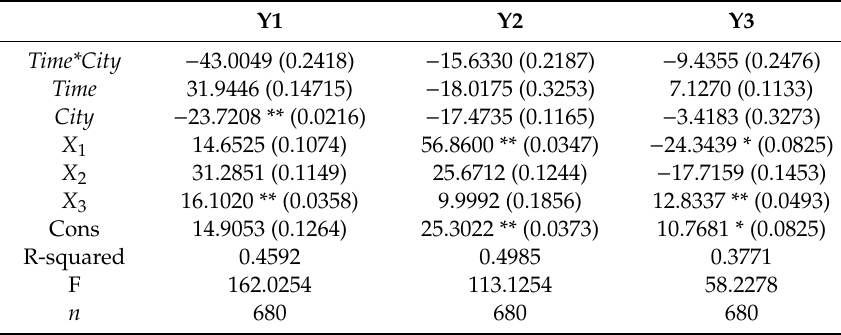
Table 11. Test results of time point inspection.